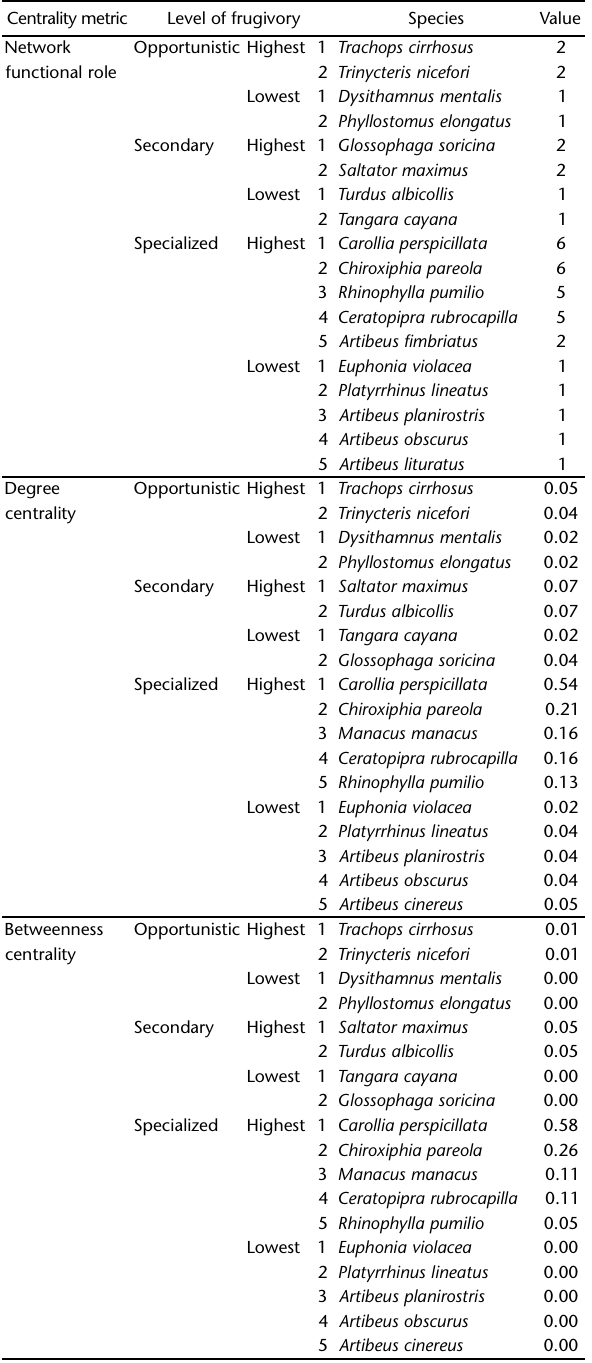
Table III. Some specialized frugivores, such as the bat Carollia perspicillata and the bird Chiroxiphia pareola , were the only species to reach extreme values of all centrality metrics, although there were no differences on average in centrality among categories of dietary